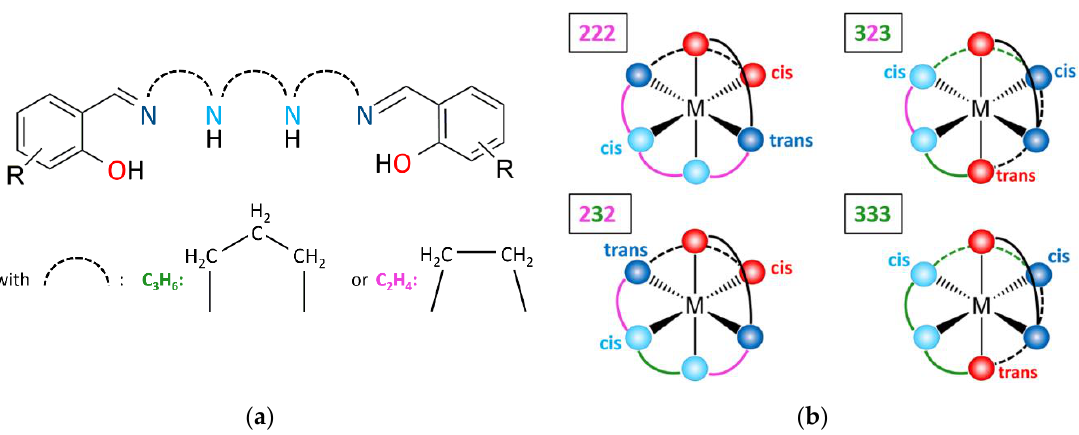
Figure 1. ( a ) Depiction of hexadentate ligands with different chain lengths and ( b ) resulting coordination geometry around a trivalent 3-D metal ion. Table 1. Donor orientations and spin states for Fe(III) and Mn(III) complexes with selected